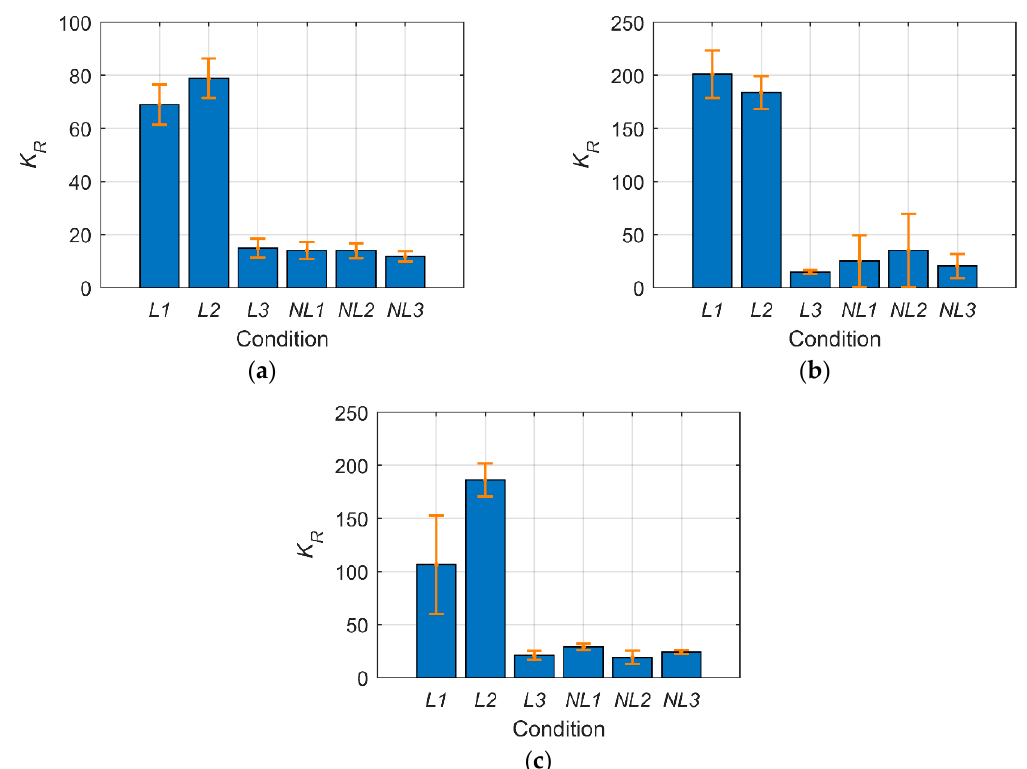
Figure 5. Mean values of K R in Test-2 ( ± σ R intervals indicated by the orange vertical bars), for sensors: ( a ) Ard; ( b ) Aax; ( c ) Hyd.